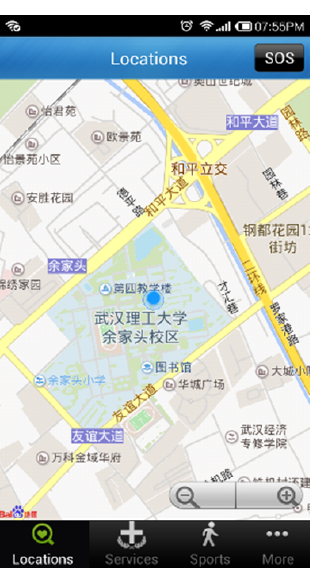
Fig. 7. Activity-aaService customized with user’s geo-localization